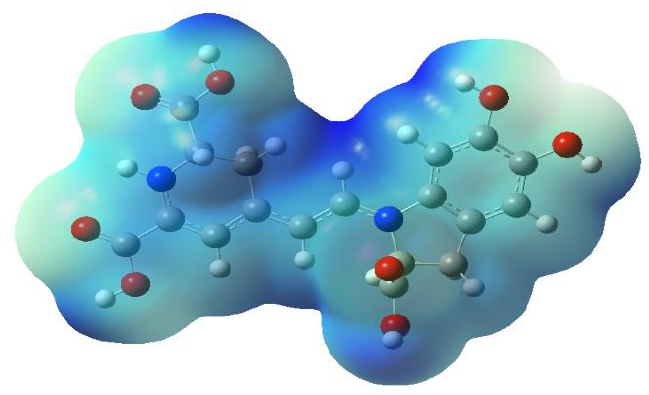
Figure 3. Map of electrostatic potential for Bd (isovalue = 0.02 density = 0.0004).